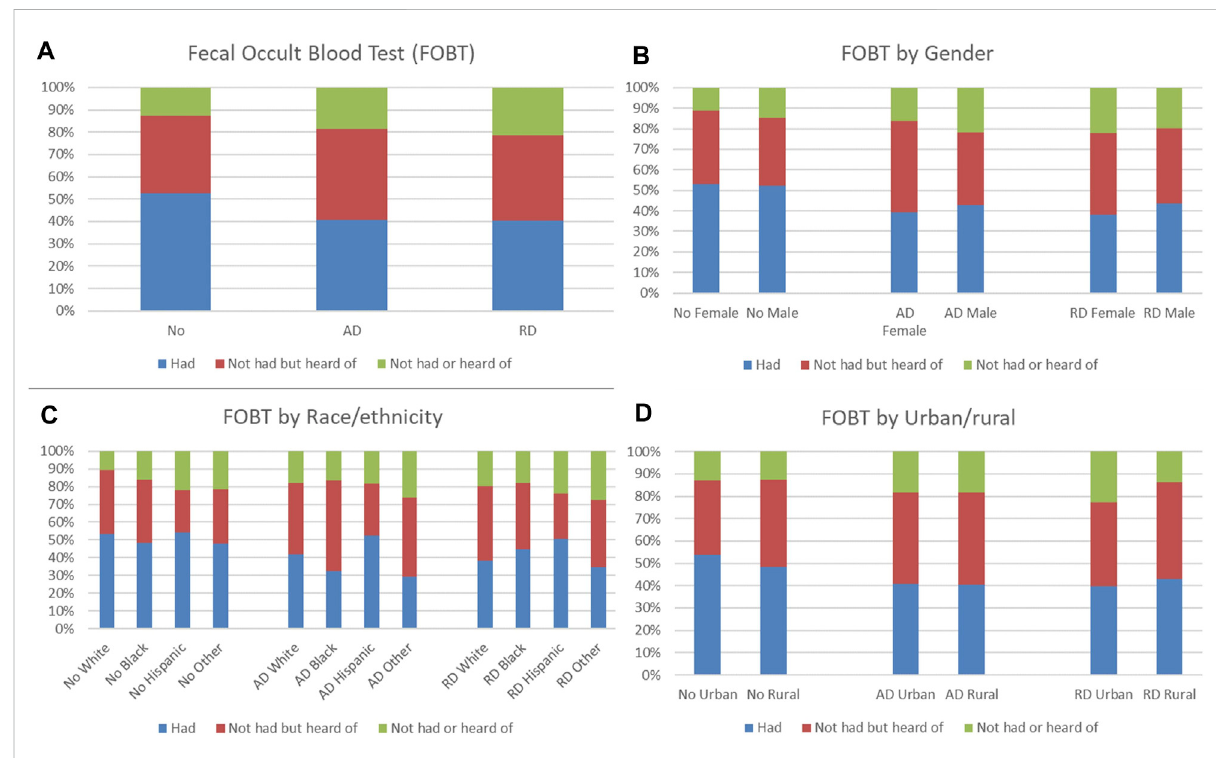
FIGURE 2 Distribution of fecal occult blood test (FOBT) use and knowledge by ADRD status (A) . Overall distribution; (B) . Distribution by gender; (C) . Distribution by race/ethnicity; (D) . Distribution by